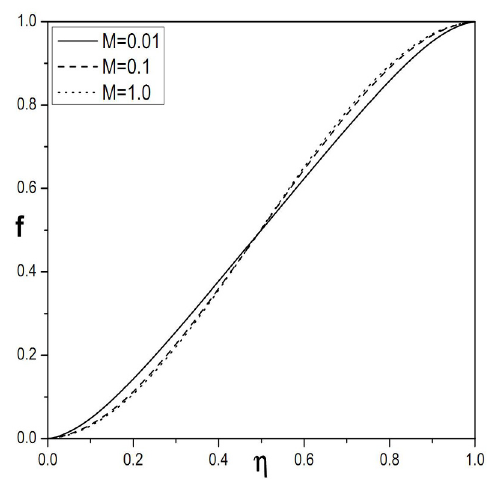
Figure 7. Effect of magnetic parameter M on ï±Ćow velocity when Re = 0 . 5